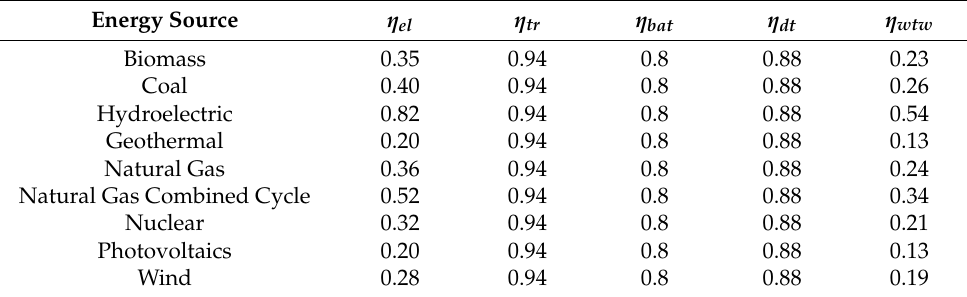
Table 1. Components of well-to-wheels efficiencies for EVs. Energy